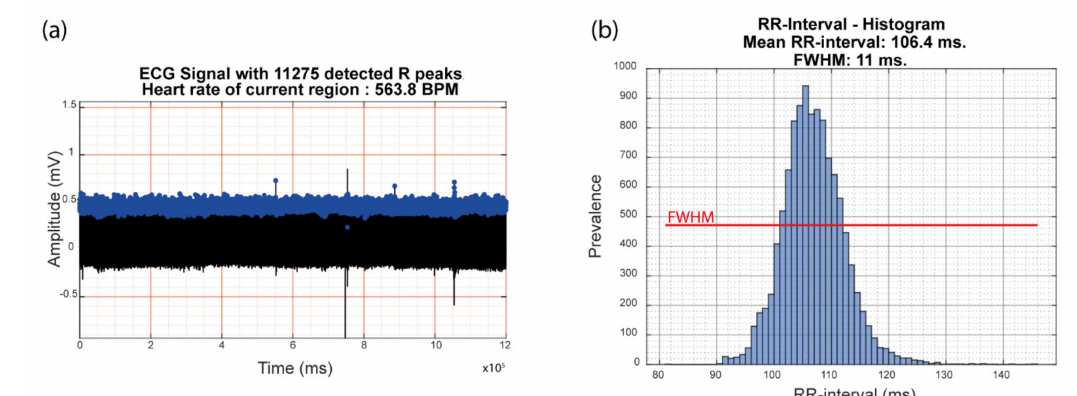
Figure 4. Graphical user interface presentation of the automatically calculated ECG parameters after running the custom MATLAB ® scripts on a representative twenty-minute murine ECG trace. ( a ) Detected R-peaks are visualized with blue dots on the (compressed) murine ECG trace. Total amount of detected R-peaks and calculated heart rate is presented in the title of the graph. ( b ) Histogram representing the distribution of the observed RR-intervals. X-values are subdivided in intervals of 1 ms. Automated calculation of the mean RR-interval and Full-Width at Half-Maximum (representative for heart rate variability) is presented in the title of the graph. The level of the Full-Width at Half-Maximum value is visualized by means of a red line within the graph. ECG; electrocardiogram, BPM; beats per minute, FWHM; Full-Width at Half-Maximum.